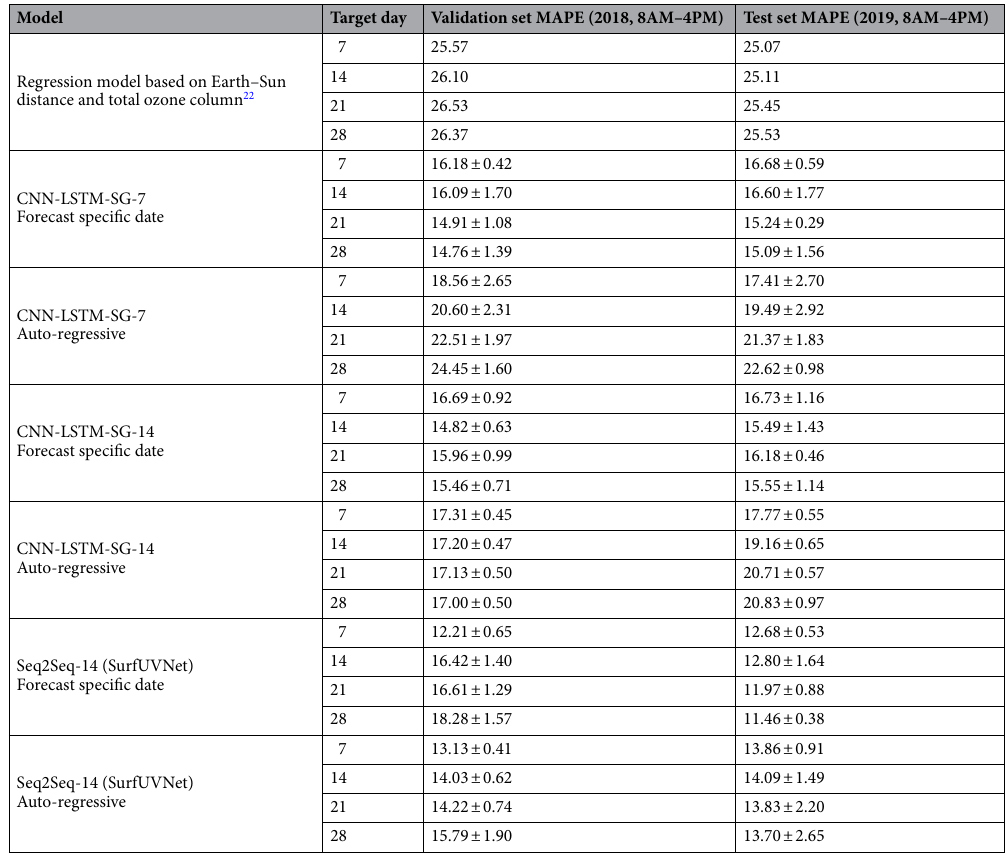
Table 3. Mean absolute percentage errors (MAPE) for long-term antipsoriatic irradiance forecasting for up to 28 days into the future on Nakhon Pathom